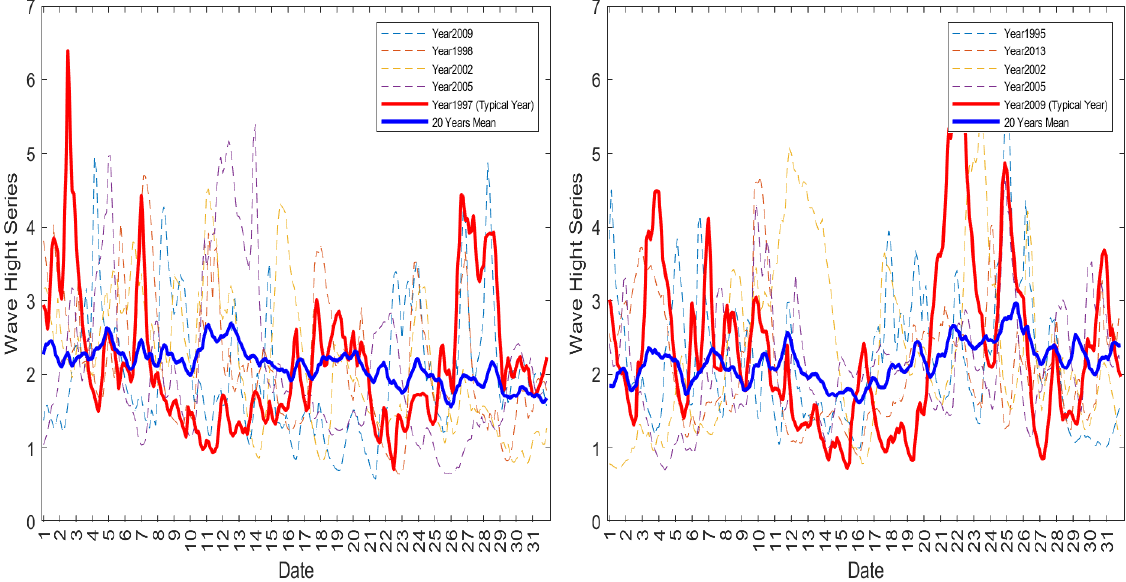
Figure 5. The significant wave height time series of March ( left ) and October ( right ) from the most representative years identified by the component of temporal synchrony.